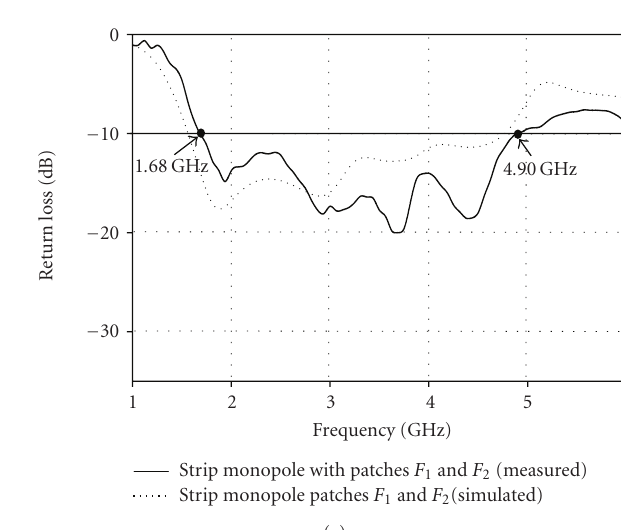
. 4], (b) strip monopole with patch F r = 4